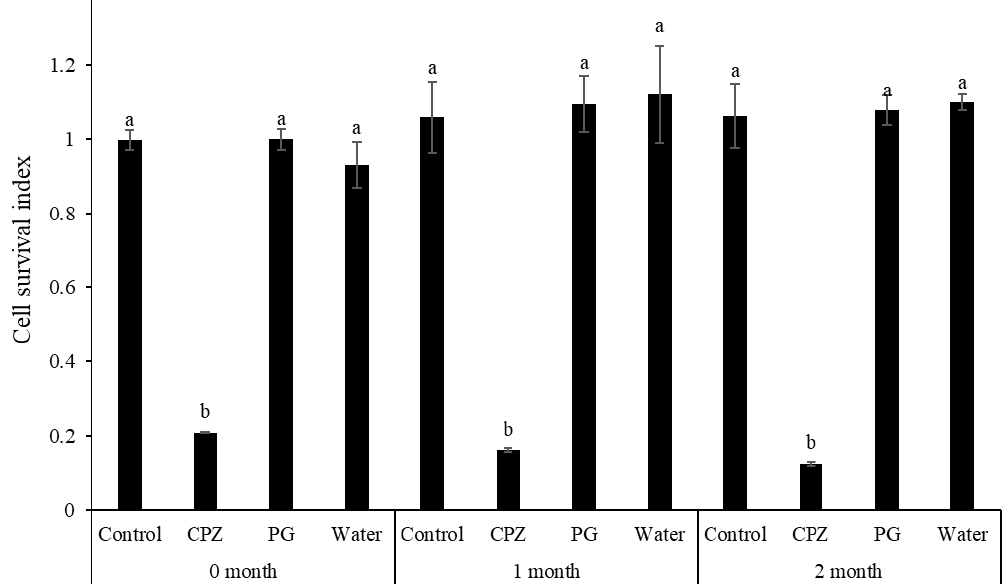
Figure 6. Evaluation of the phototoxic potential under UVA exposure of Scutellaria baicalensis extract (SBE) stored in 20% PG and water for different numbers of months to human keratinocytes. The data are presented as the mean ± SD (n = 3). Letters indicate significant differences within each experiment at p < 0.05.